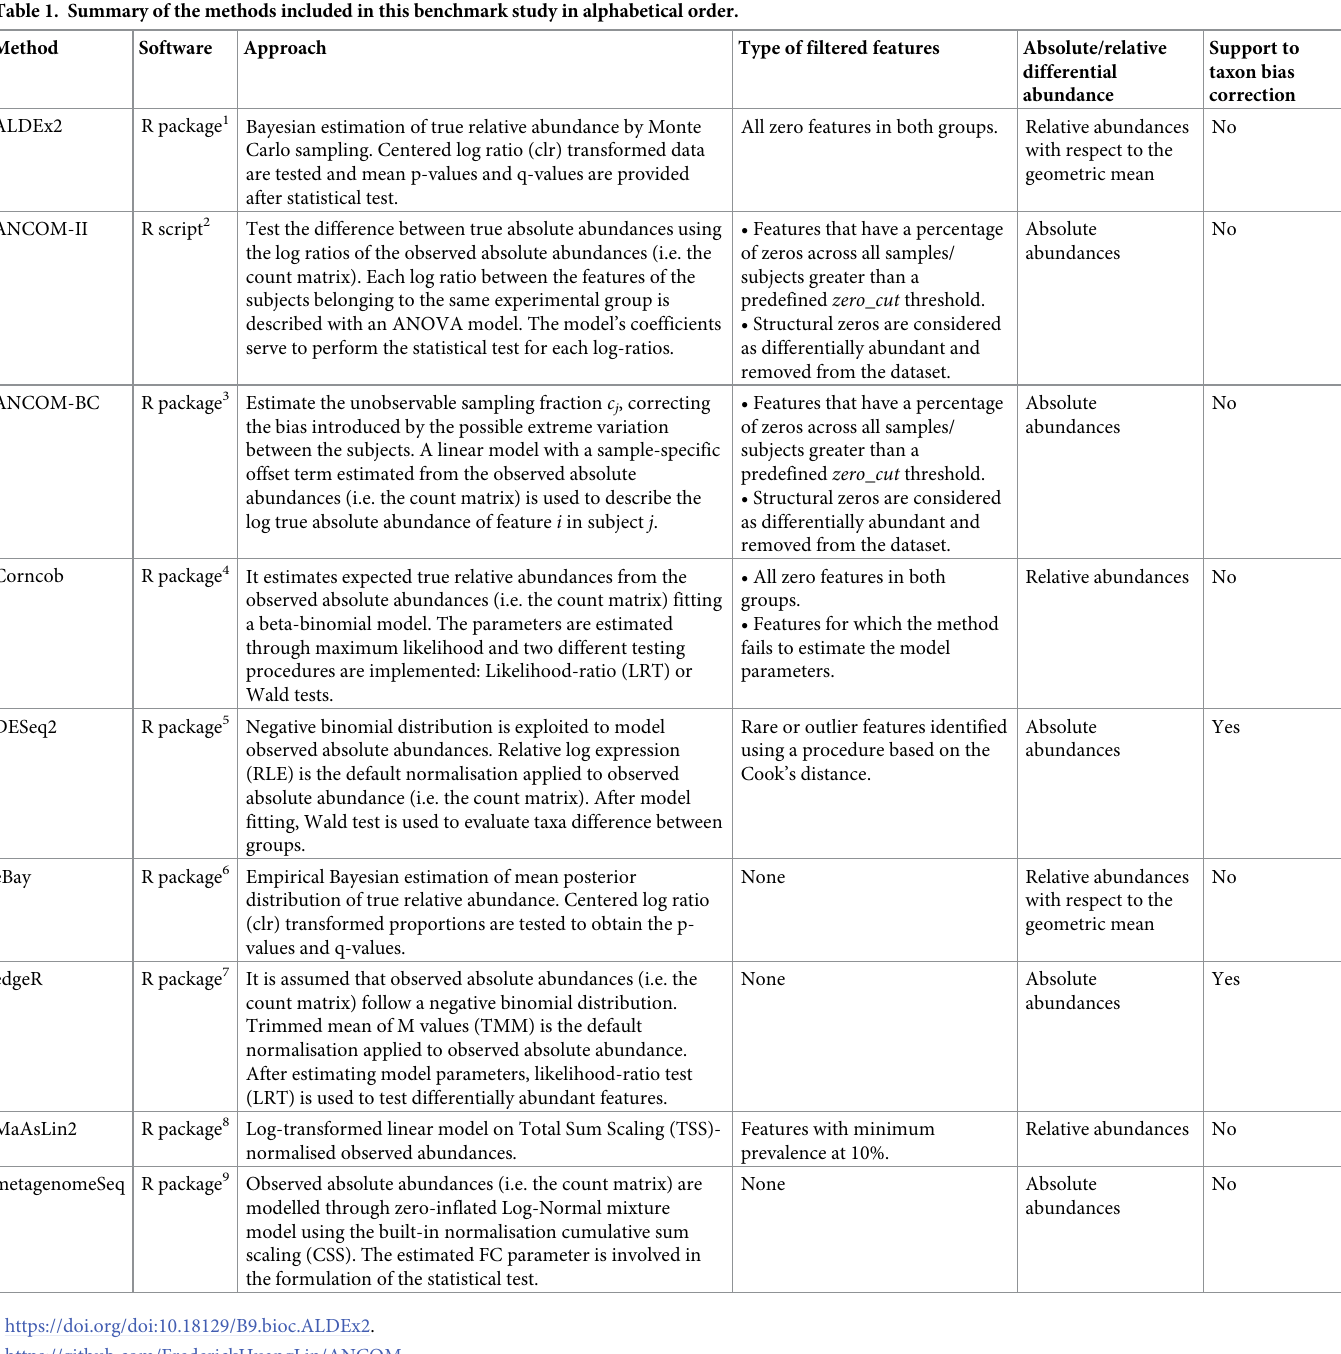
Table 1. Summary of the methods included in this benchmark study in alphabetical